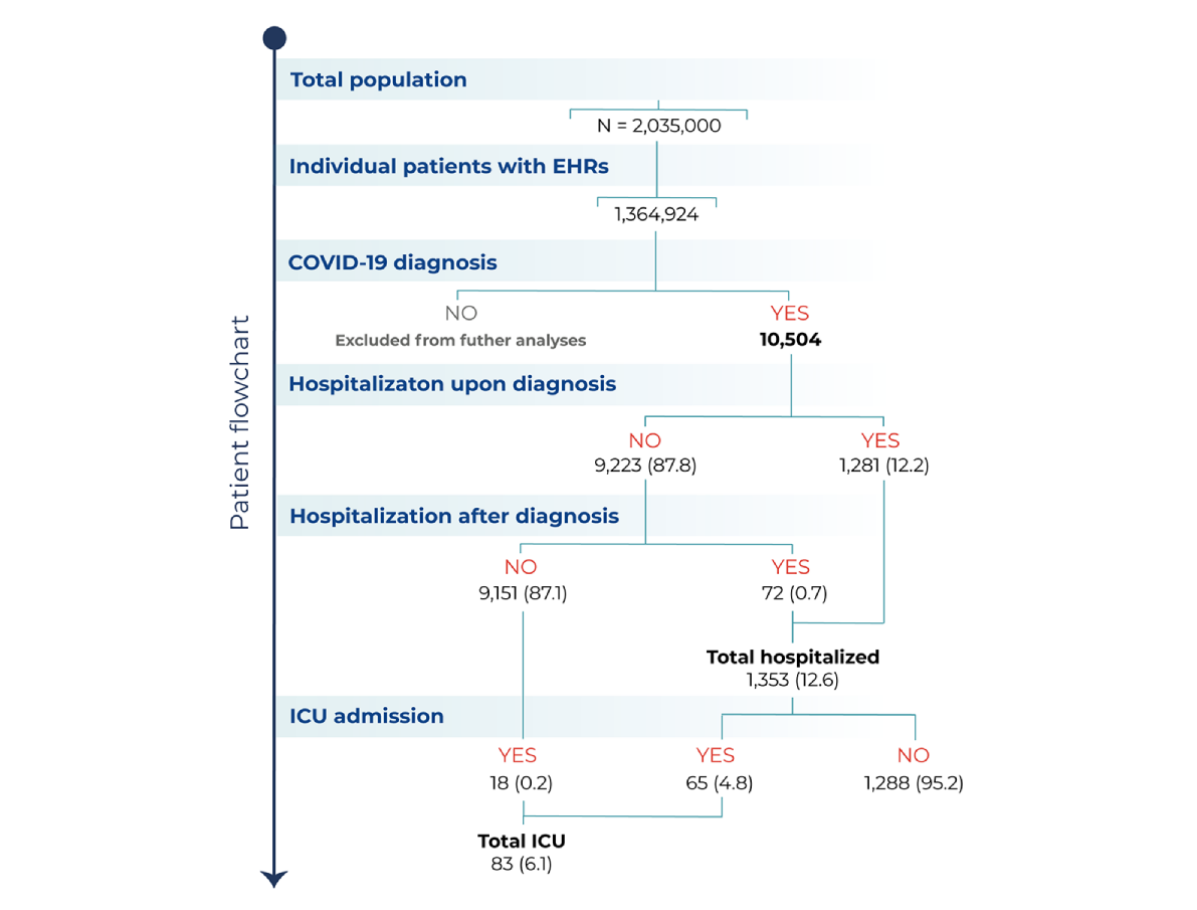
Figure 2. Patient flowchart depicting the total number of inhabitants in the source population, the number (%) of patients with available EHRs analyzed, the number of patients diagnosed with COVID-19, and of those, the number of hospitalizations and ICU admissions. EHR: electronic health record; ICU: intensive care